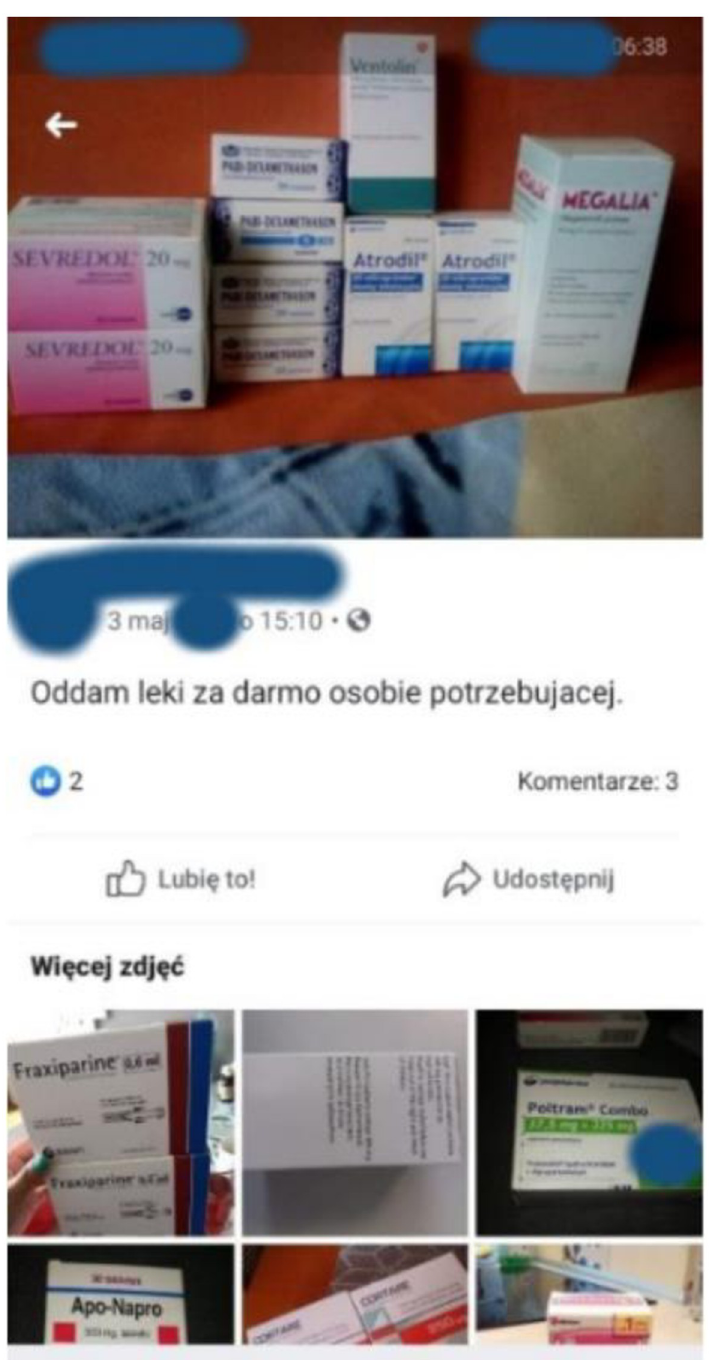
Fig 1. The example of the illegal online trade of medicines. Offer including morphine (Sevredol 1 ) and tramadol (Polram Combo 1 ). Source: Facebook. The URL address was not collected and is not reported to avoid the possible traceability of the Facebook user and to not to contravene the data protection or the GDPR. The presented figure is similar but not identical (partial screenshot with concealed parts of the picture) to the original image and is therefore only for illustrative